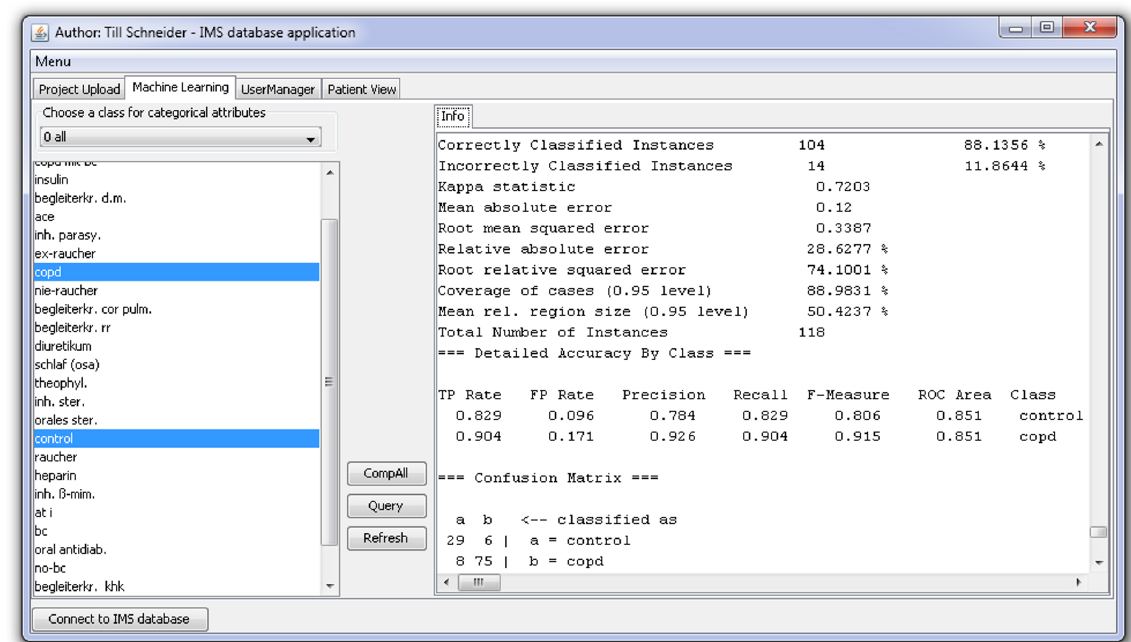
Figure 4: This snapshot of the database application presented in this work illustrates the decision tree classification performance, which is retrieved by means of a ten-fold cross-validation, for a target dataset comprising the labels (classes) COPD vs. control